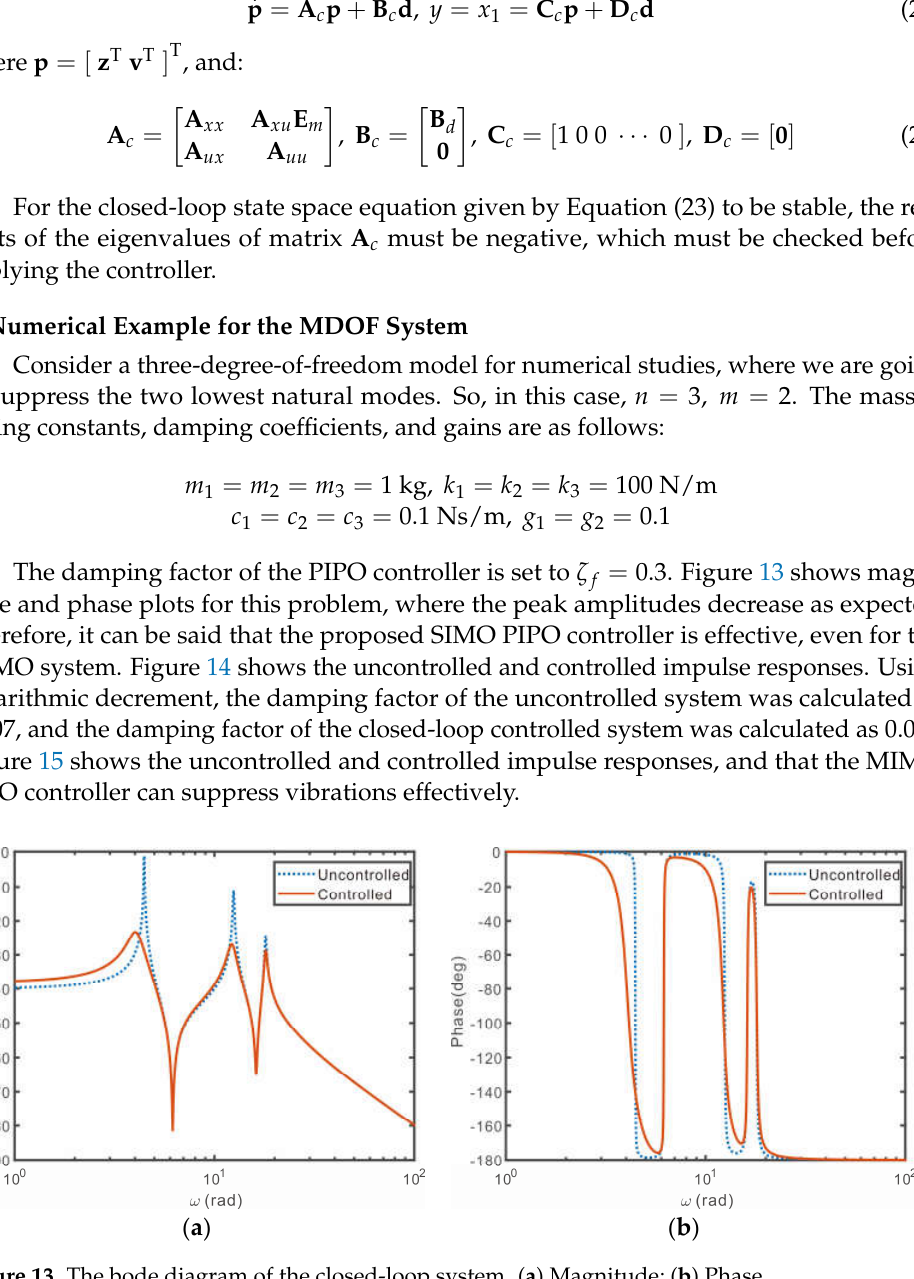
Figure 14. Free vibration experiment (the first mode excited). Figure 15. Impulse time-response of the closed-loop system.